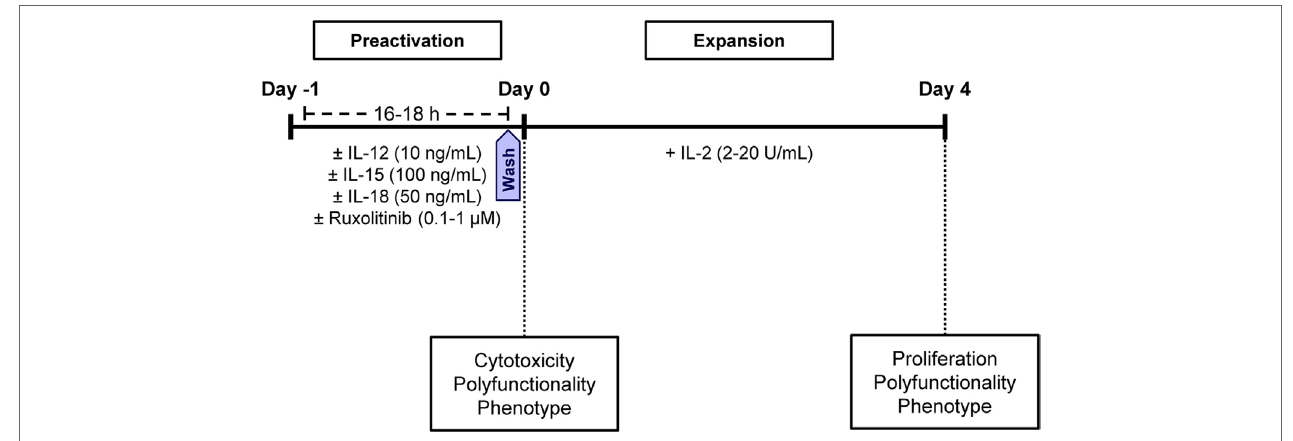
FigUre 1 | Graphic representation showing the culture conditions of natural killer (NK) cells. During the preactivation phase (16 –18 h), cells were stimulated with different combinations of IL-12, IL-15, and IL-18 in the presence and absence of ruxolitinib. During the expansion phase, NK cells were cultured with IL-2 for 4 days. At the end of the preactivation and expansion phases, the phenotype and effector functions of NK cells were